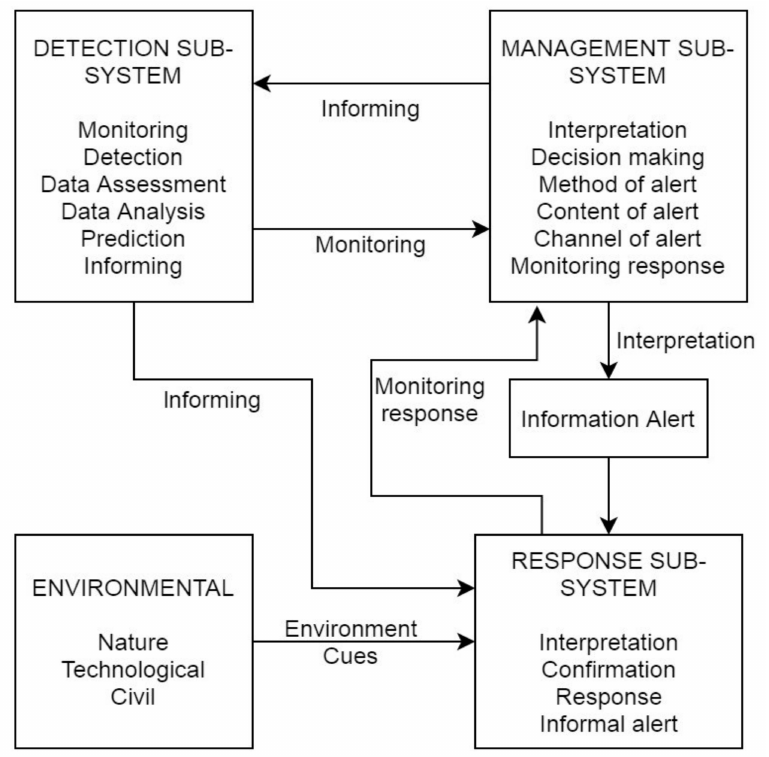
Figure 6. Systemic approach to analyze policy making for micro-mobility during